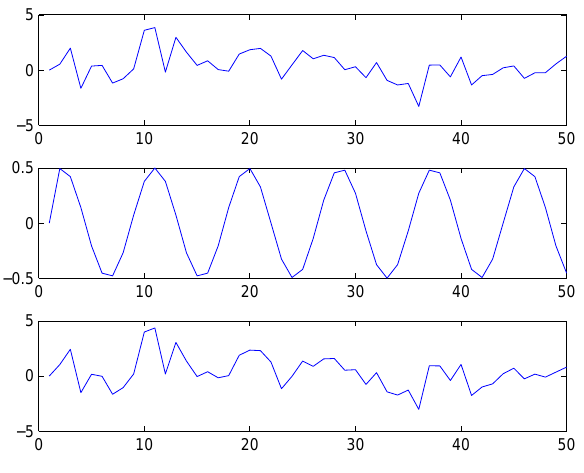
Figure 2: (Top) AR1 process with AR1 coefficient 0.3 and noise variance 1. (Middle) a pure sinusoid of period 8.8. (Bottom) The sum of top signal and middle signal